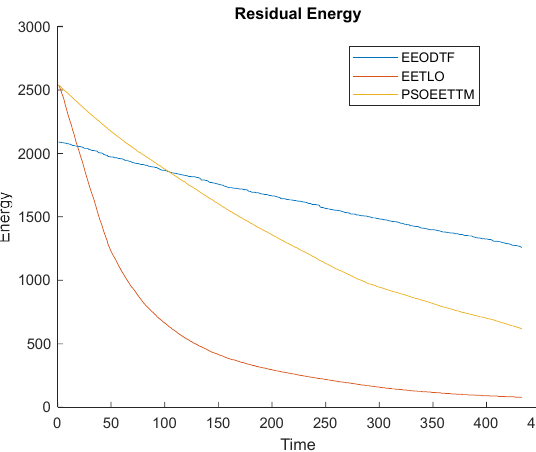
Figure 12. Residual energy of network vs. time.